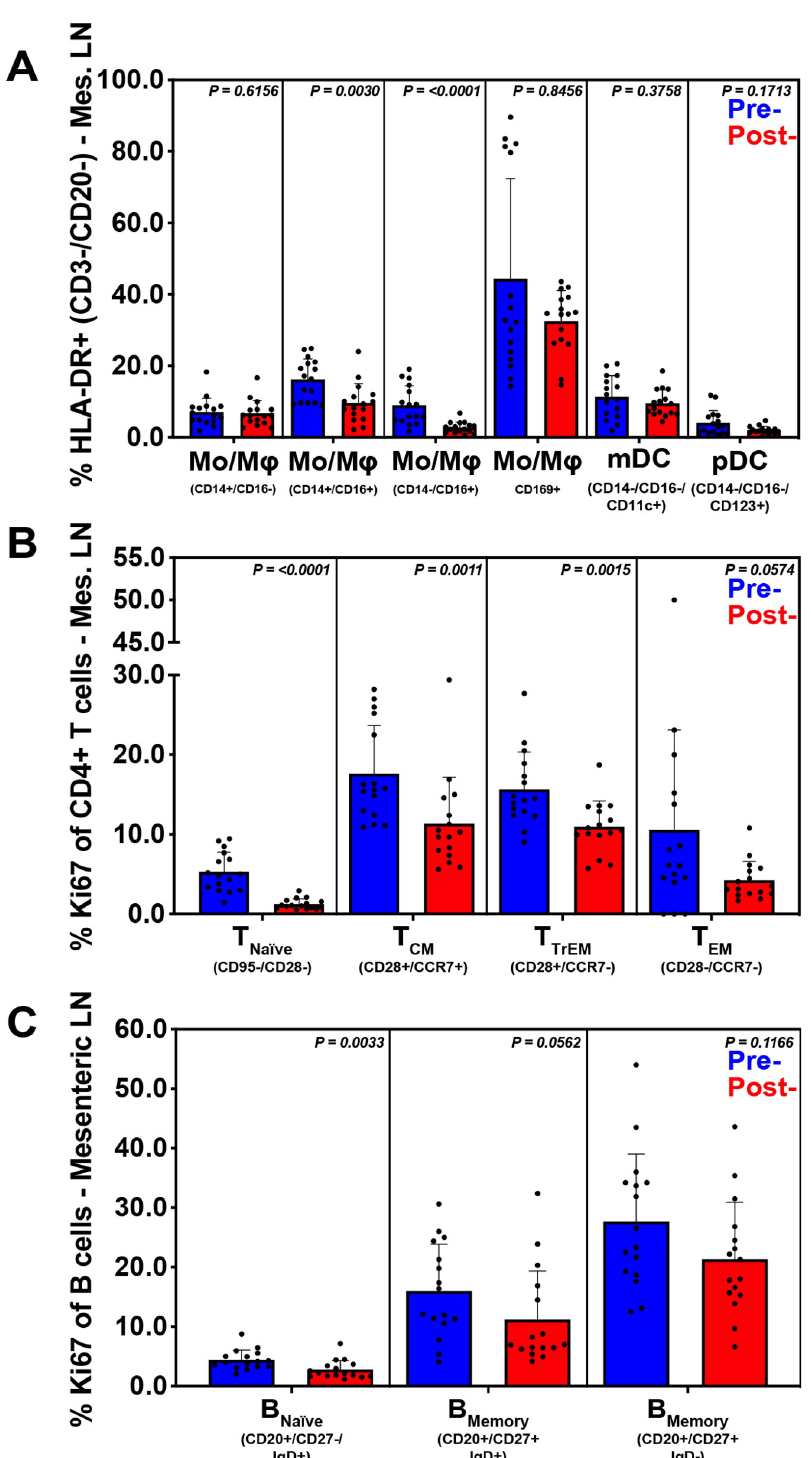
Fig 7. Inflammation and immune activation at GI-tract draining sites are reduced following short course multimodal therapy. Flow cytometric analysis was performed on B cells, CD4+ T cells, DCs, and MOs derived from mesenteric lymphoid tissue, before and after multimodal treatment. Subsets were summed for overall responses with the figure showing the mean (+ SEM) of these overall responses both pre- and post-treatment. A reduction in both CD14+ CD16+ and CD14- CD16+ monocytes was observed, as well as a decreased SEM for CD169+ expression by all HLA-DR+ cells ( A ). A reduction of the proliferation marker Ki67 and reduced SEM post-treatment in CD4+ T